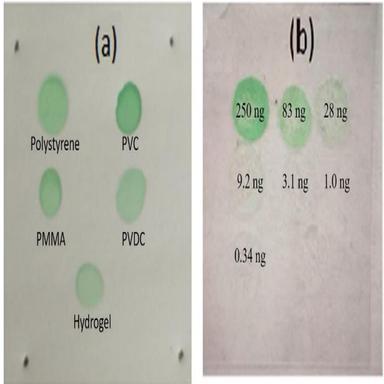
Exemplary photographs of arrays of the phosphorescent coatings with 250 ng of PtBP dye in the different polymers (a) and with decreasing PtBP concentrations in one polymer (seven serial 1:3 dilutions) (b), spotted on planar solid support. Spot size is 2-3 mm across.